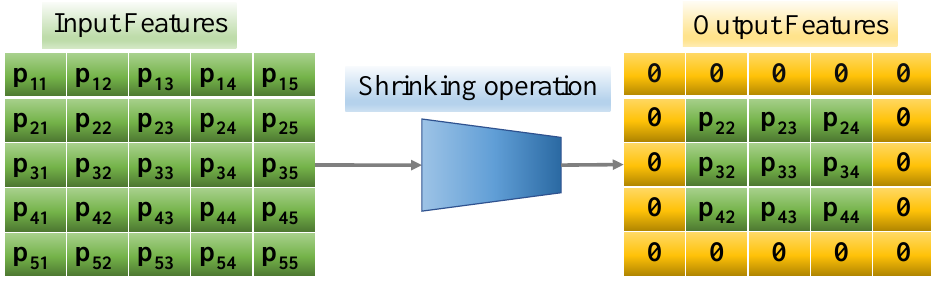
Figure 4. Demonstration of the shrinking layer operation (insert zeros to the outside boundary).